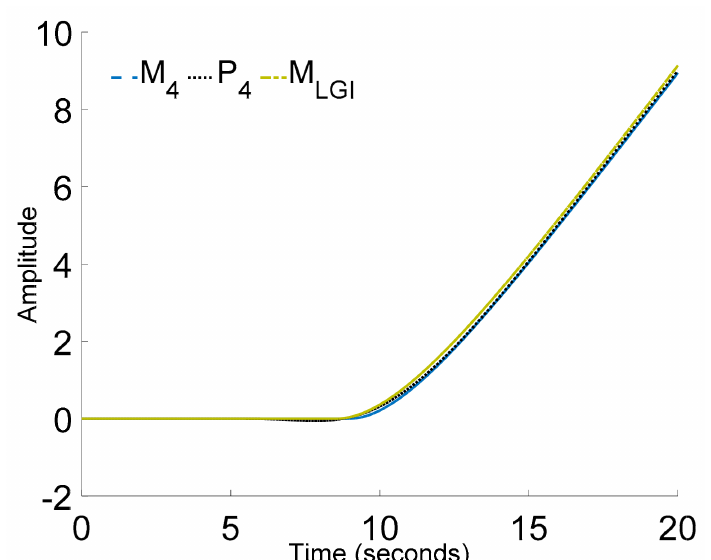
Figure 19. The unit step responses of process P 4 ( s ), model M 4 ( s ), and model M LGI ( s ).